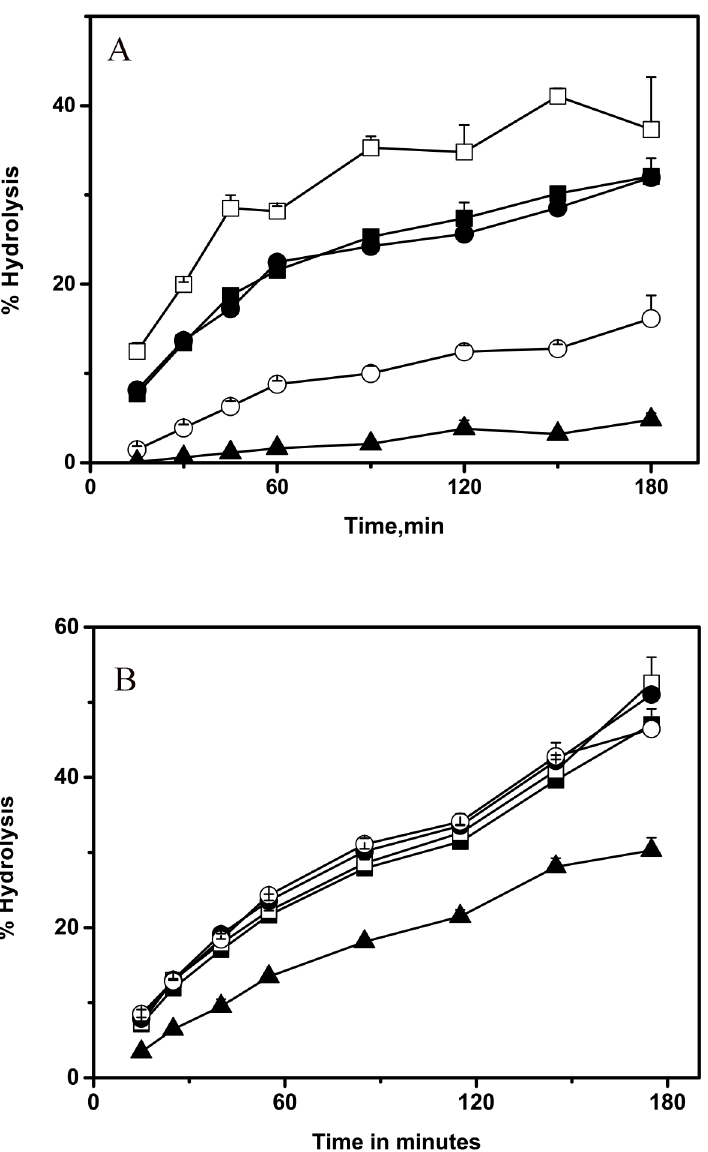
Fig 3. Time course of hydrolysis of anchovy oil and fatty acid distribution in the hydrolysate. Anchovy oil was subjected to hydrolysis by PLA1 (A) and BSL (B). The reaction product at various times was subjected to methylation and GC analysis. Percent hydrolysis of each fatty acid was calculated based on its hydrolysis at t x as a fraction of t o . Saturated ( □ ), Monounsaturated ( ● ), EPA ( (cid:1) ), DHA ( ▲ ), Total hydrolysis ( ■ ).